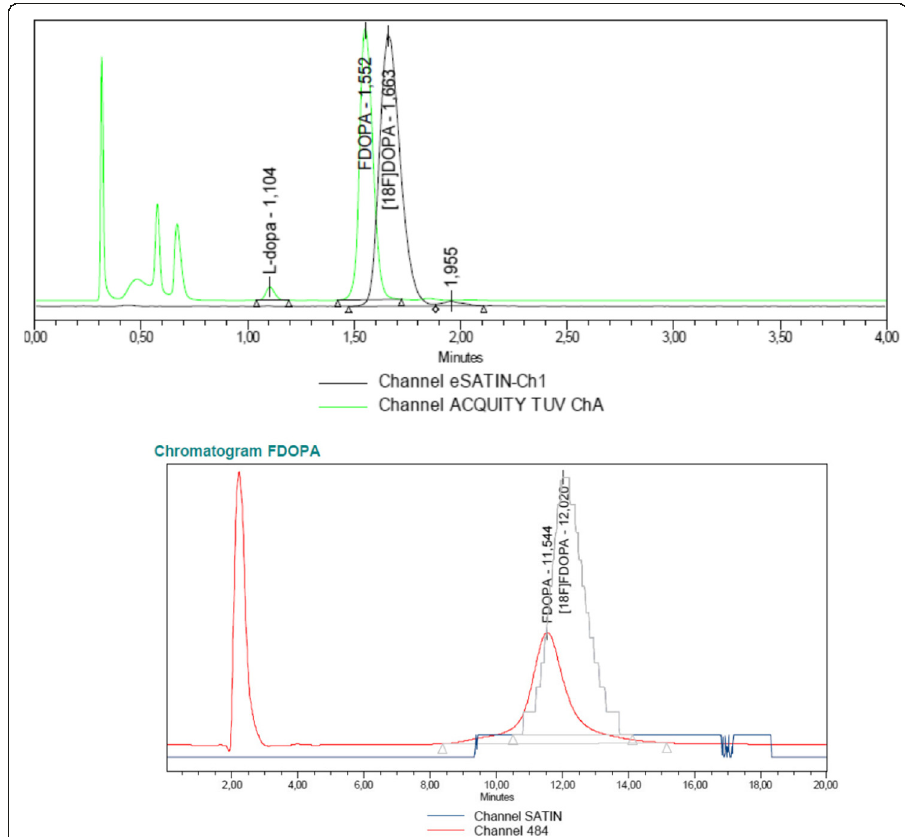
Fig. 3 An example of a typical chromatogram of FDOPA -L performed with UPLC-UV and radioactivity detector ( upper ). Green is UV and the black line is RA signal. Notice that because the different detector position there is a delay in RA-signal. Below , a typical presentation of a chromatogram of FDOPA -L